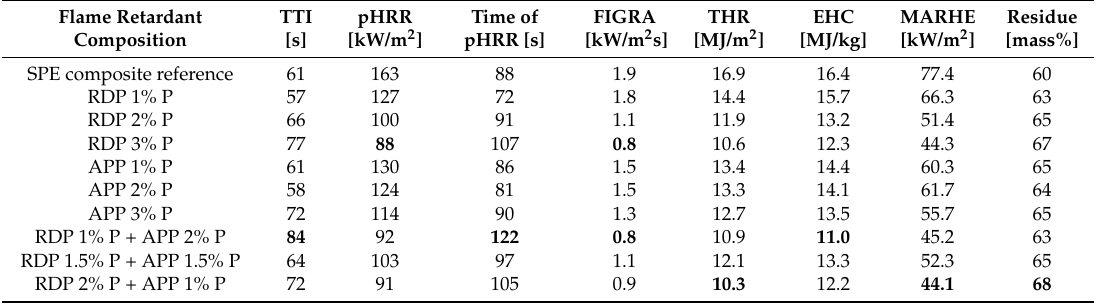
TTI: time to ignition, pHRR: peak of heat release rate, FIGRA: fire growth rate, THR: total heat release, EHC: average effective heat of combustion, MARHE: maximum of average rate of heat emission, average standard deviation of the measured mass loss calorimeter values: TTI: ±3, pHRR: ±30, time of pHRR: ±5, residue: ±2.